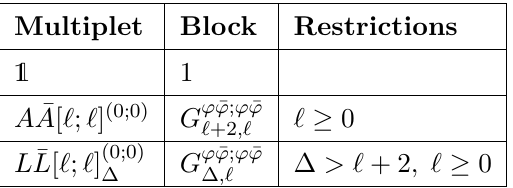
Table 3 . List of multiplets that appear in the ϕ r × ¯ ϕ − r OPE, where ϕ r is the primary of an N = 2 chiral multiplet and ¯ ϕ − r is its complex conjugate. The explicit form of the superconformal block is given in (2.16). The multiplets A ¯ A [ ‘ ; ‘ ] (0;0) for ‘ ≥ 1 contain higher-spin conserved currents and should be absent in an interacting